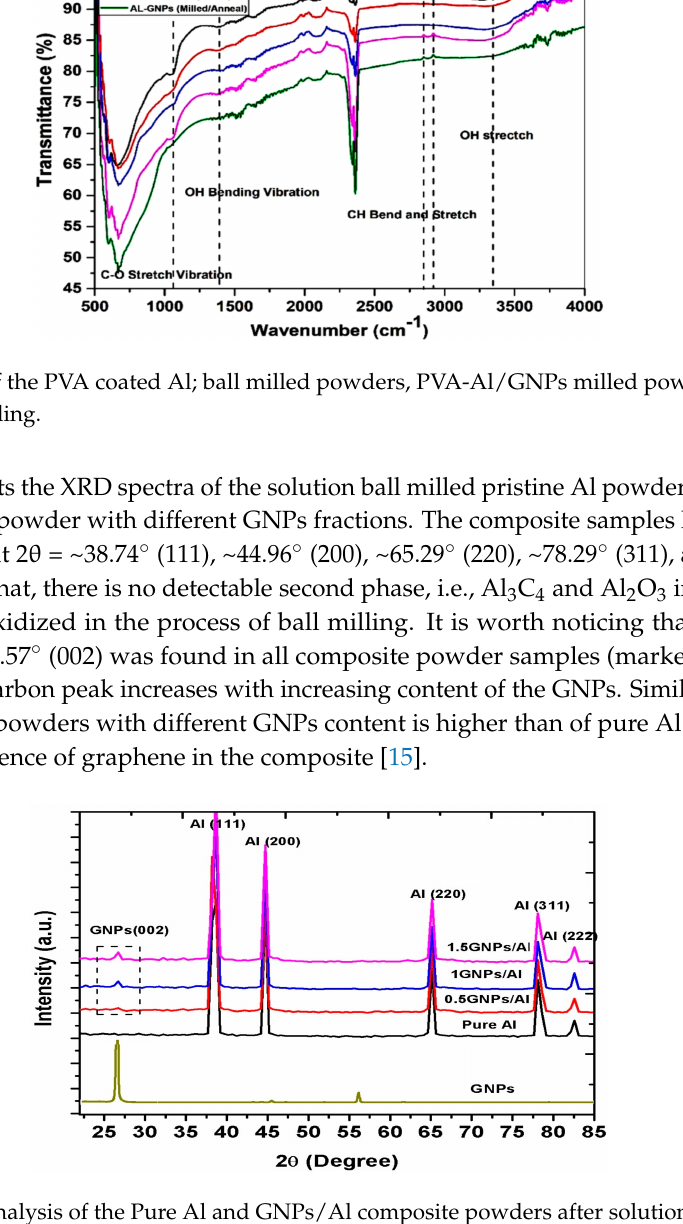
Figure 12. XRD analysis of the Pure Al and GNPs/Al composite powders after solution ball